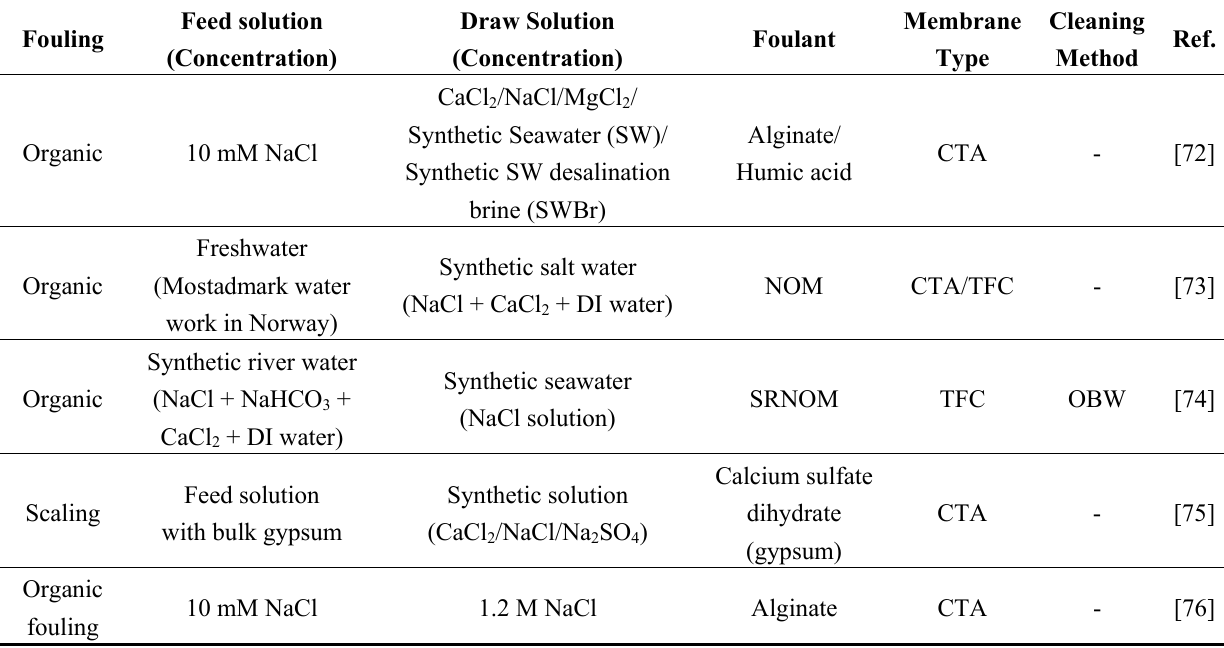
Table 5. Fouling and cleaning studies on PRO